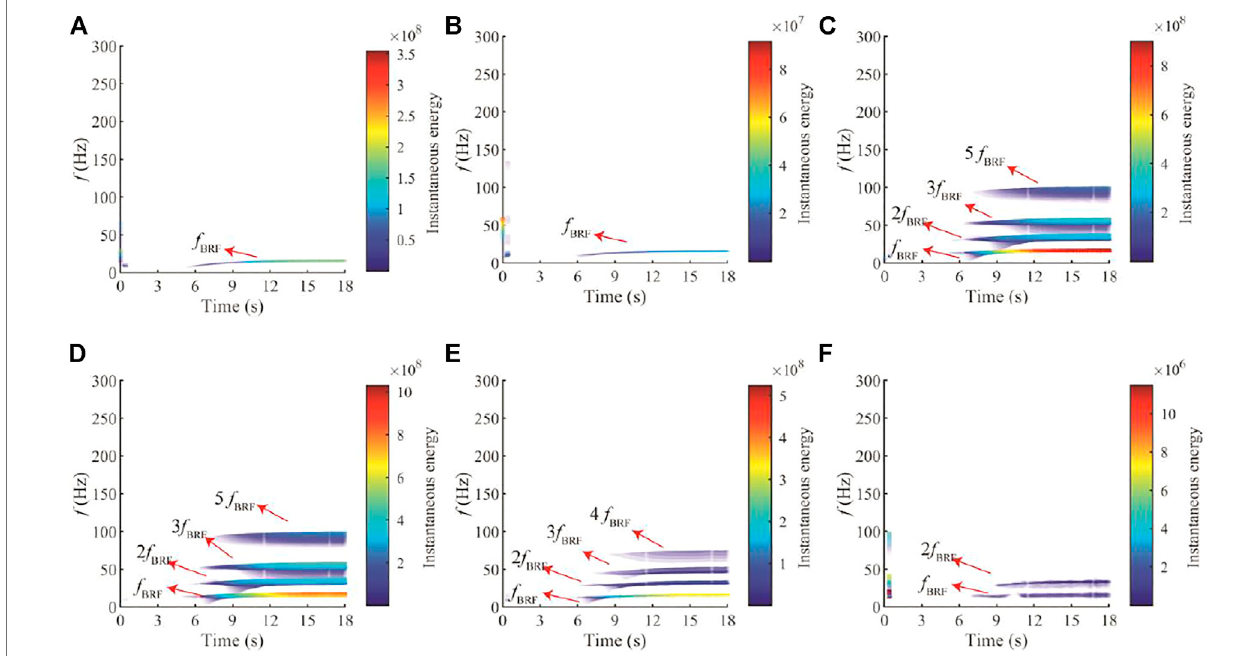
FIGURE 16 | Hilbert spectrum of monitoring points: (A) P2; (B) P3; (C) P4; (D) P5; (E) P6; (F) P7.